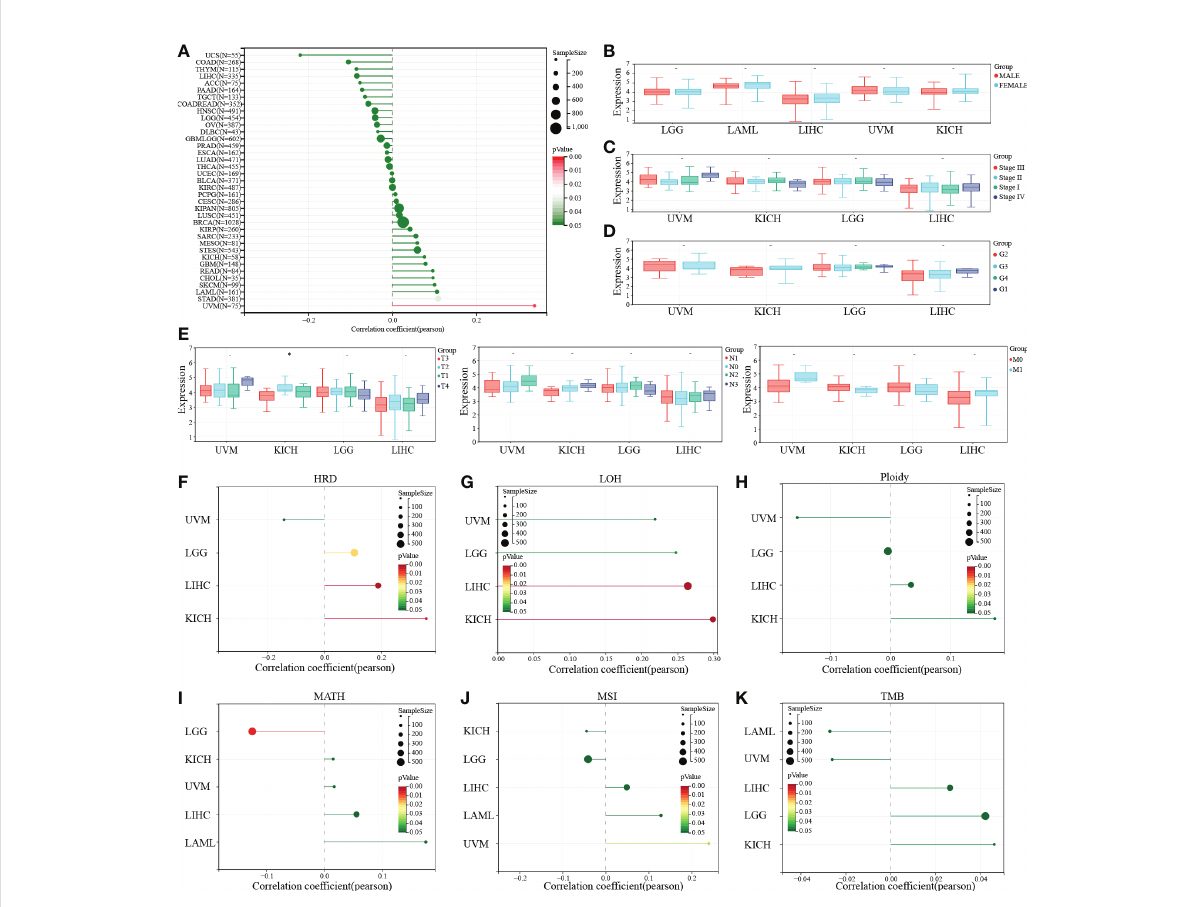
FIGURE 5 PTP1Bandclinical characteristicsincancers. (A-E) The correlationof PTP1Bexpressionand age (A) , gender (B) , stage (C) ,grade (D) andTNM (E) incancers. (F) RelationshipbetweenPTP1Bexpressionandgenomicheterogeneity, includingHRD (F) , LOH (G) ,ploidy (H) , MATH (I) , MSI (J) andTMB (K)